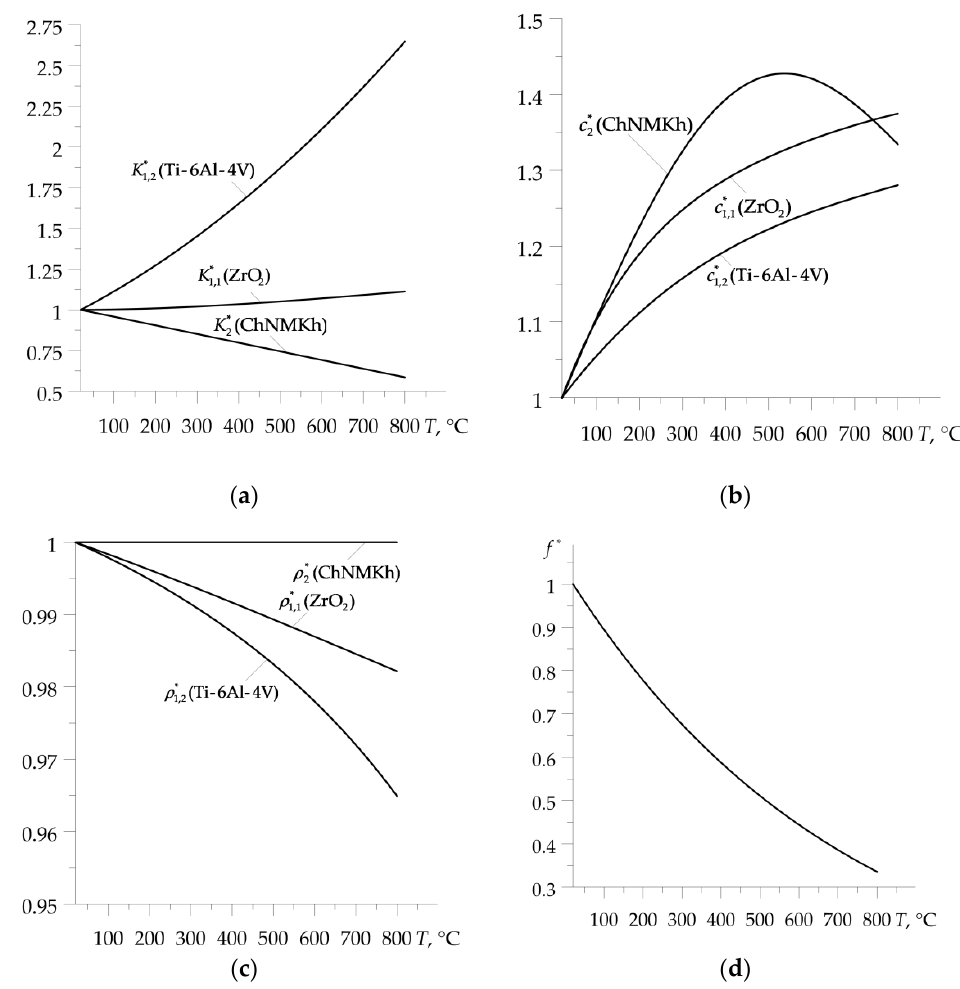
Figure 2. Temperature dependencies of the dimensionless material properties: ( a ) coefficient of thermal conductivity; ( b ) specific heat; ( c ) density; and ( d ) friction coefficient of the considered friction pair.